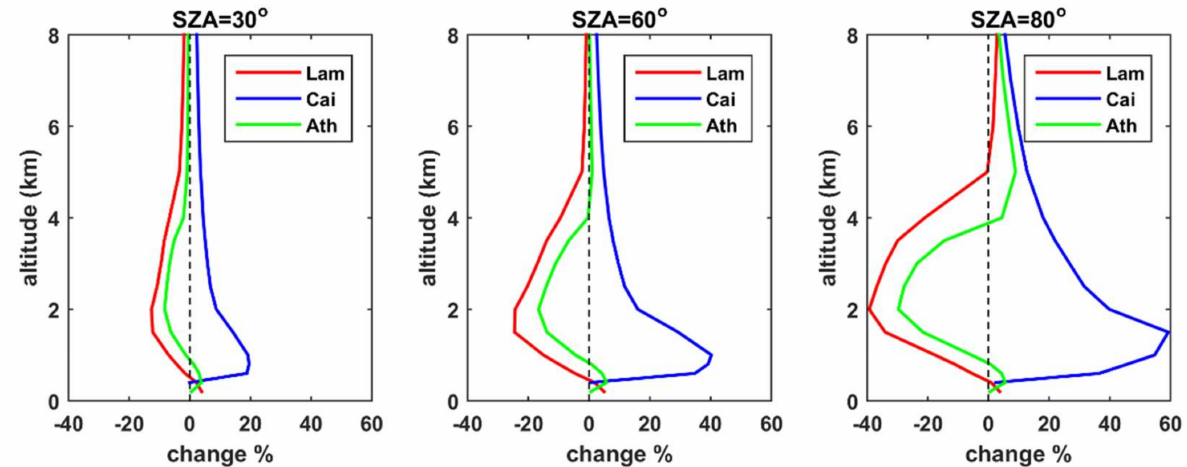
Figure 14. Change (in %) in AF in the UV in the first 8 km of the atmosphere due to the use of the LIVAS profiles instead of the default libRadtran profile for AOD = 1. Results for the three sites and for SZA = 30 ◦ , 60 ◦ , and 80 ◦ are presented in Appendix